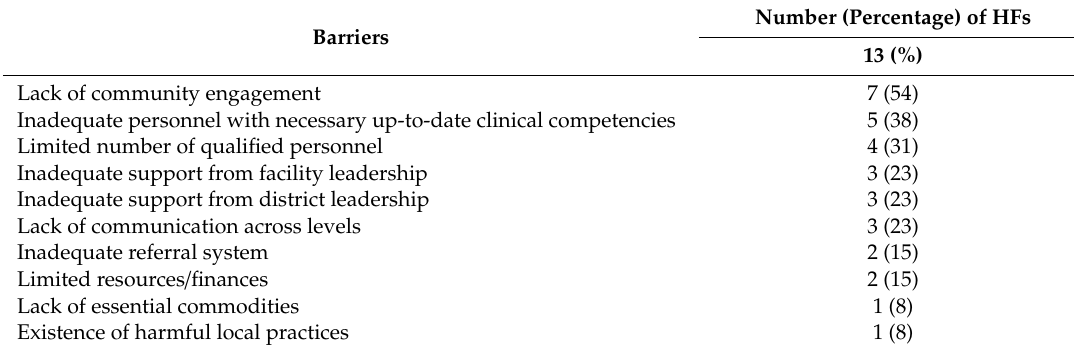
Table 2. Barriers to implementing maternal and perinatal deaths surveillance and response (MPDSR). Number (Percentage) of HFs Barriers 13 (%) Lack of community engagement 7